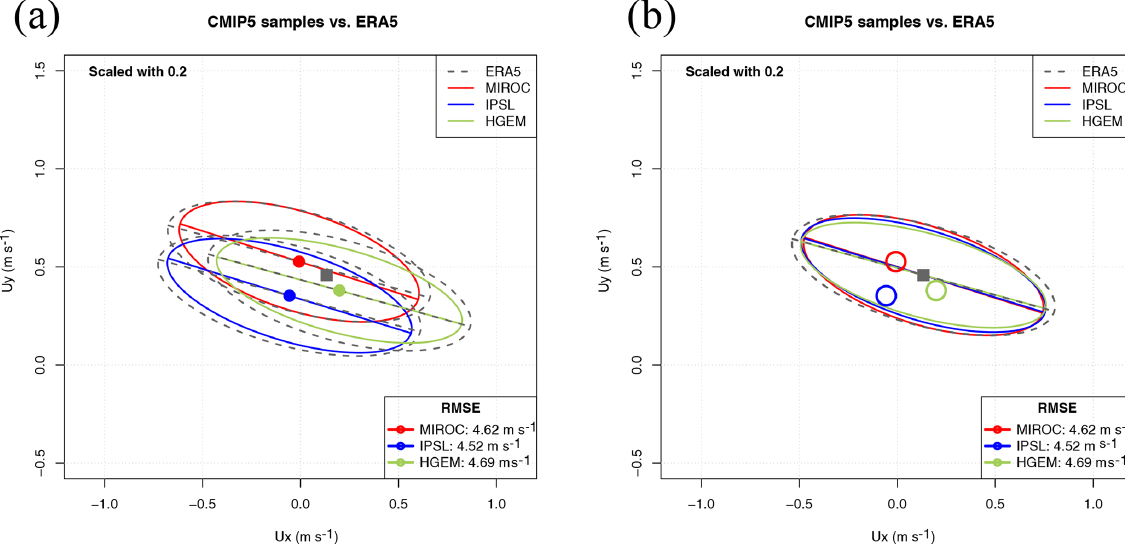
Figure 8. Sailor diagram representing the agreement between the Southern Hemisphere wind field as simulated by three models from the CMIP5 repository with ERA5 data when the reference dataset is repeated in an extended matrix. An uncentred version of the diagram (a) is compared with a centred version of the diagram (b)